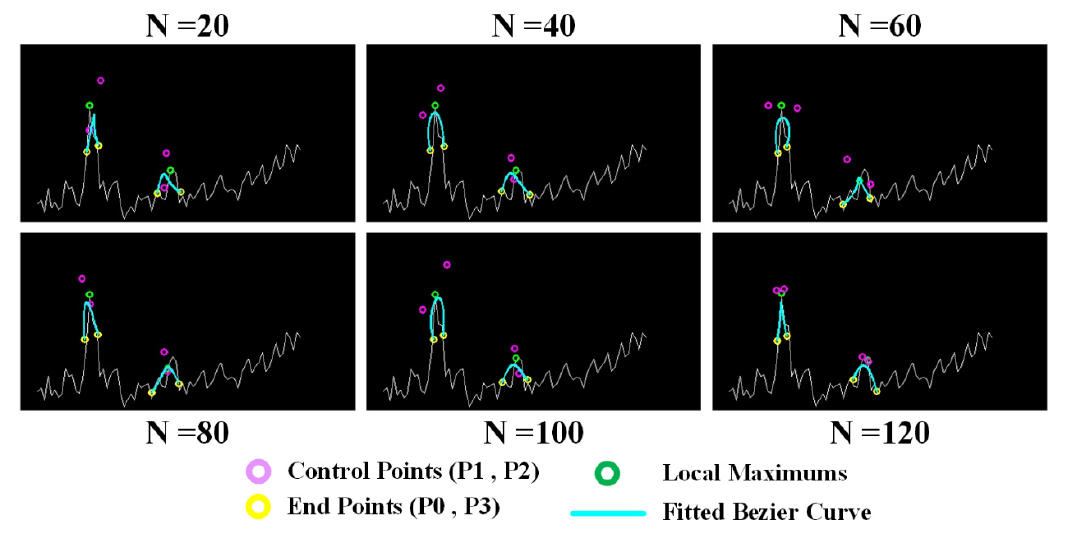
Figure 11. Bezier curve fitting results using different sample number.